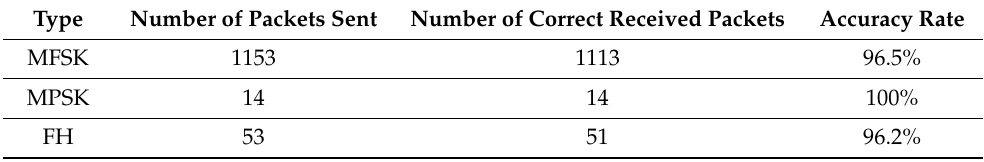
Table 3. Communication statistics of the underwater acoustic communication